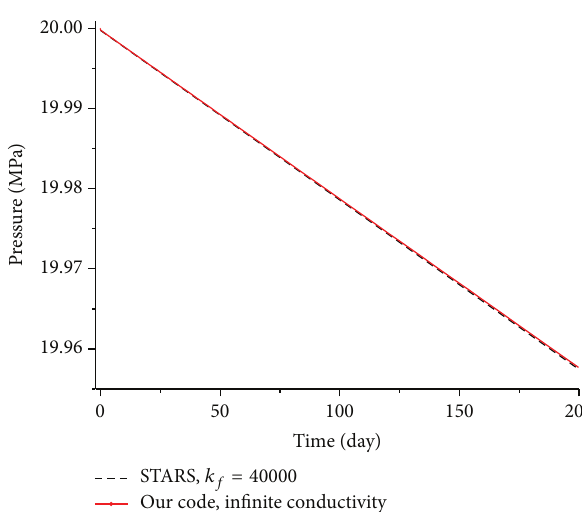
Figure 2: Comparison of bottom hole flowing